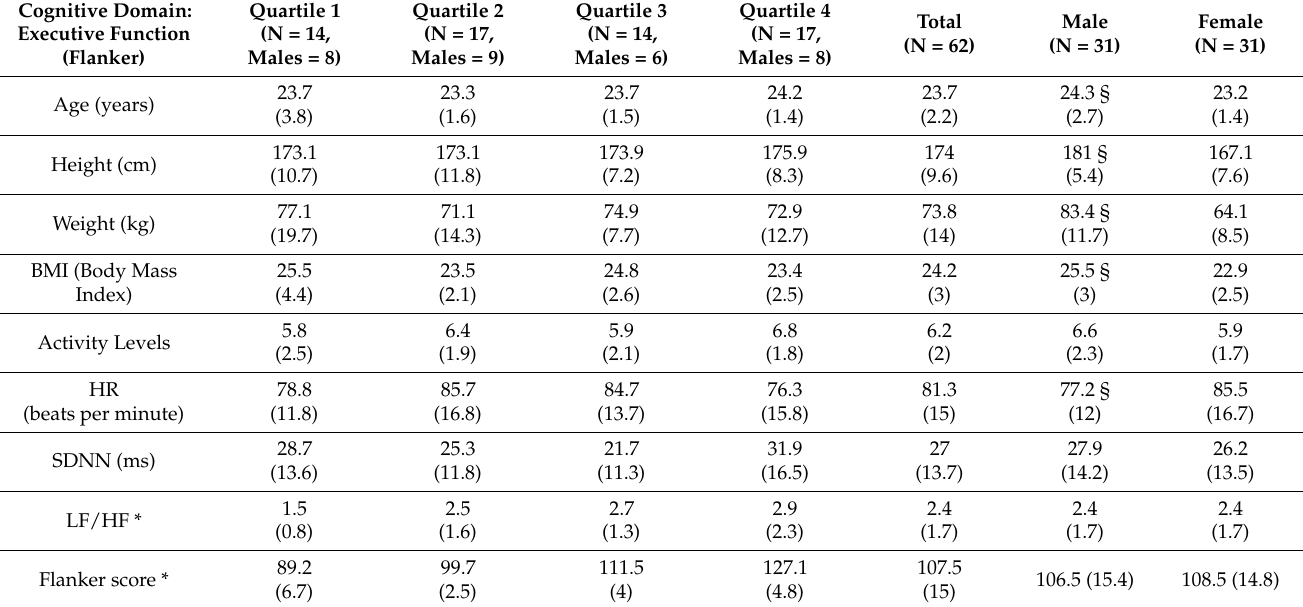
Table 3. Average (sd) age, height, weight, body mass index, activity levels, heart rate (HR), standard deviation of N–N interval (SDNN), low-frequency to high-frequency ratio (LF/HF), and Flanker testing score shown for quartiles, total, males, and females. * = p < 0.05 for comparison between lower 50% and upper 50% of quartile, §: p < 0.05 of a comparison between males and females.